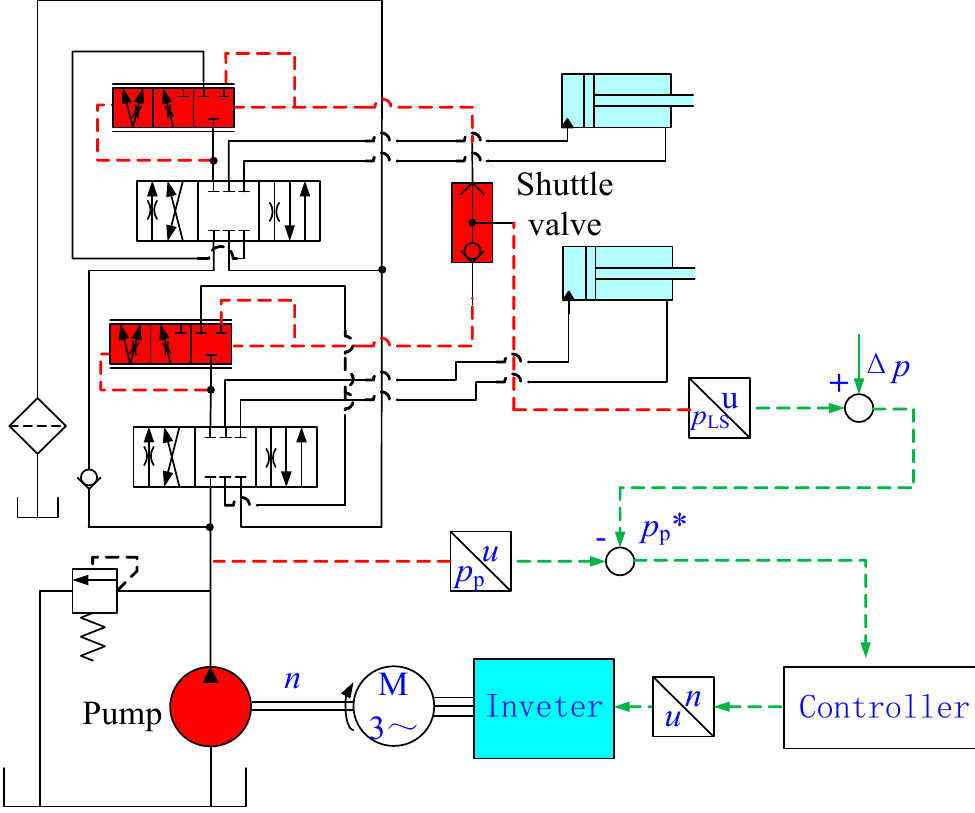
Figure 2. System schematic diagram.